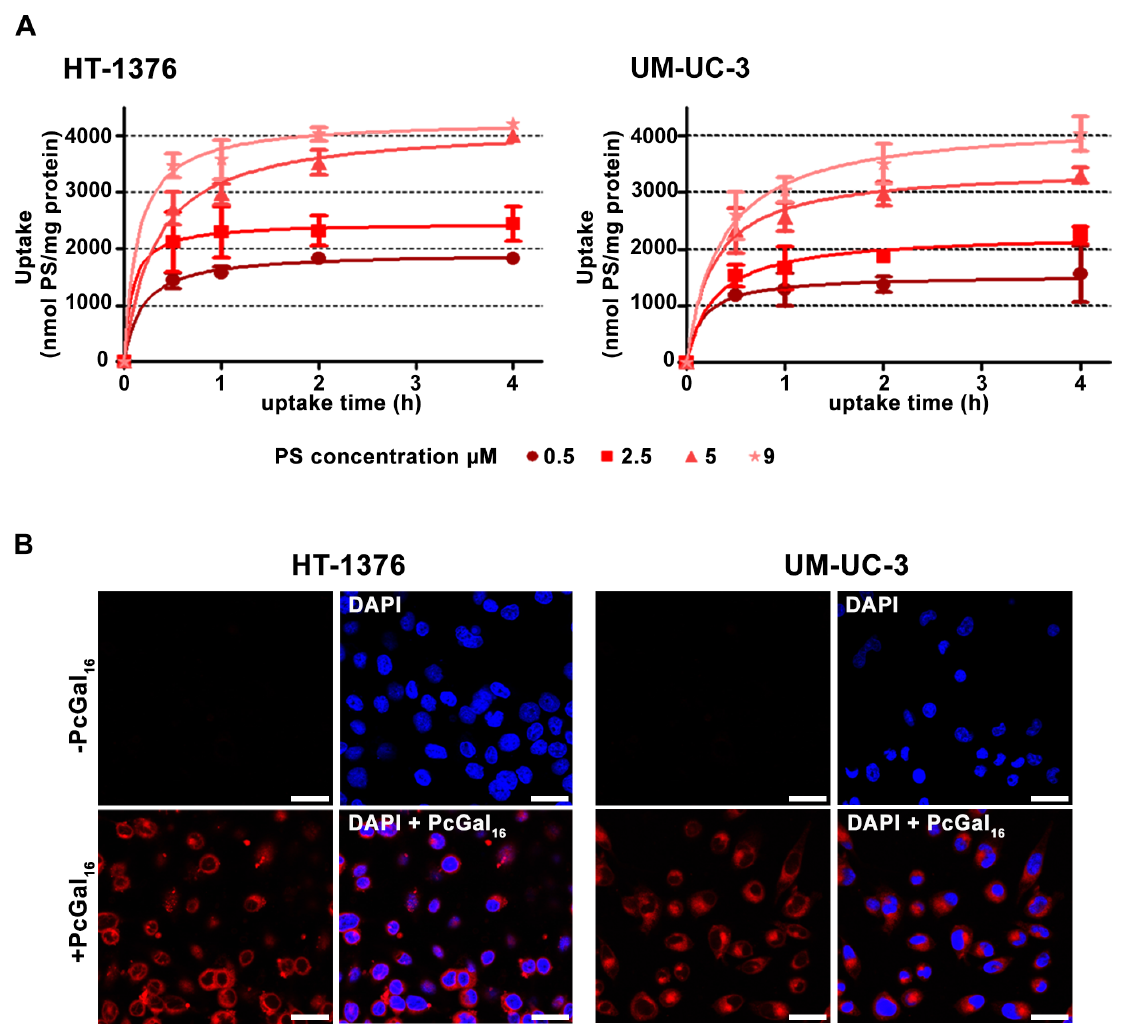
Figure 1. PcGal 16 accumulates in UM-UC-3 and HT-1376 human bladder cancer cells. Intracellular uptake of PcGal 16 by HT-1376 and UM- UC-3 bladder cancer cells (panel A). The concentration of PcGal 16 was determined by fluorescence spectroscopy and the results were normalized to protein quantity. Data are the mean 6 S.D. of at least three independent experiments performed in triplicates. Representative fluorescence images (panel B) of bladder cancer cells incubated with PcGal 16 (red) in darkness and cell nucleus stained with DAPI (blue). Scale bars 20 m